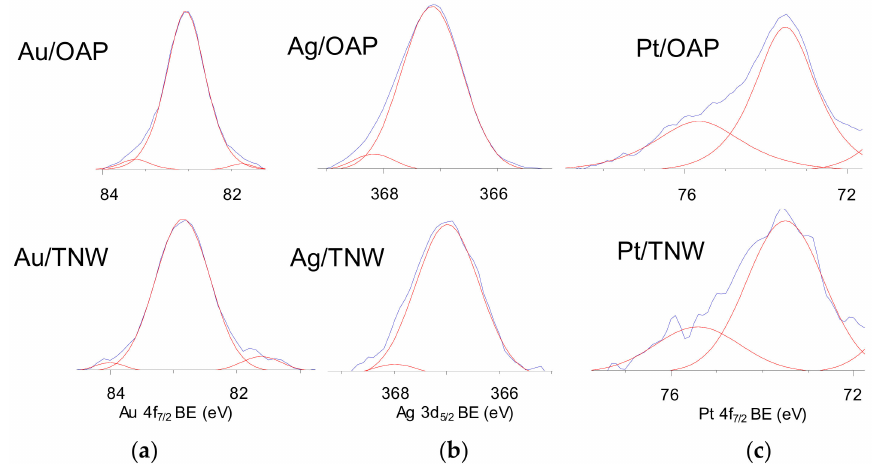
Figure 7. XPS results for Au 4f 7 / 2 , Ag 3d 5 / 2 and Pt 4f 7 / 2 for NM-modified samples: OAP (top) and TNW (bottom) for: ( a ) Au, ( b ) Ag and ( c )